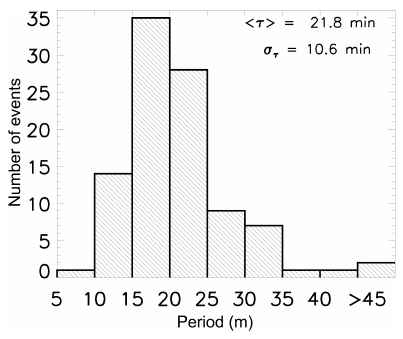
Figure 2. Histogram for the horizontal wavelength.